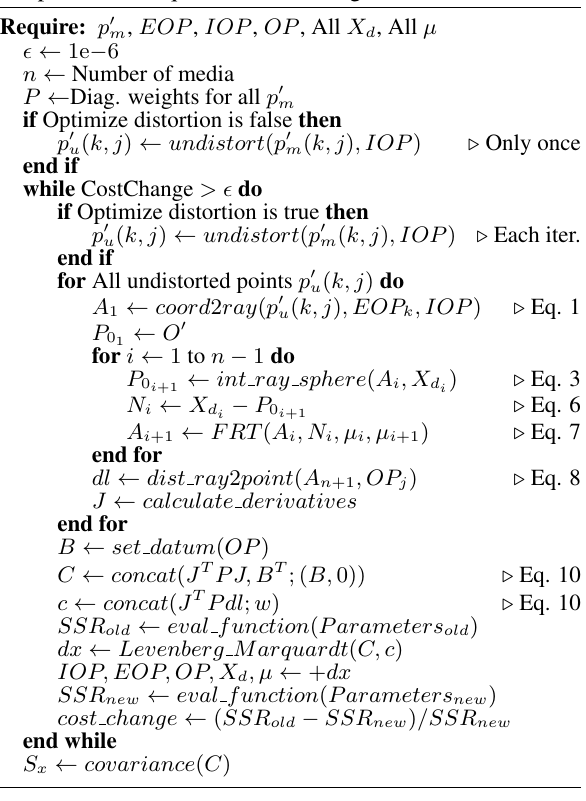
Algorithm 1 Pseudo code for the optimization algorithm to optimize the squared sum of weighted residuals SSR